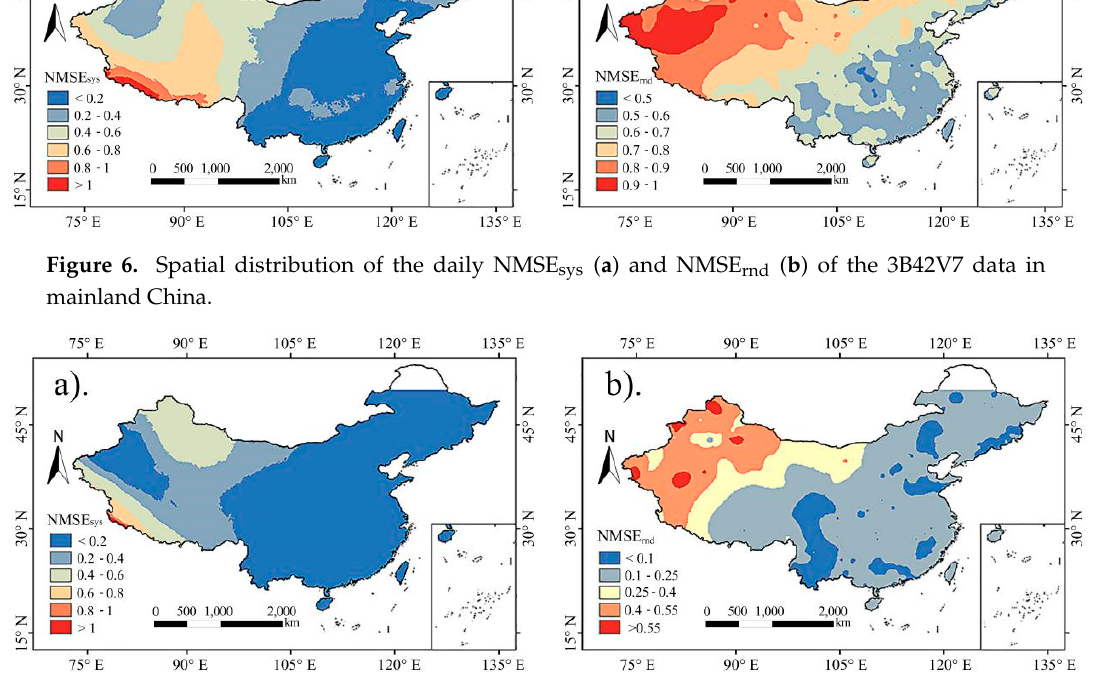
Figure 7. Spatial distribution of the monthly NMSE sys ( a ) and NMSE rnd ( b ) of the 3B42V7 data in mainland China.